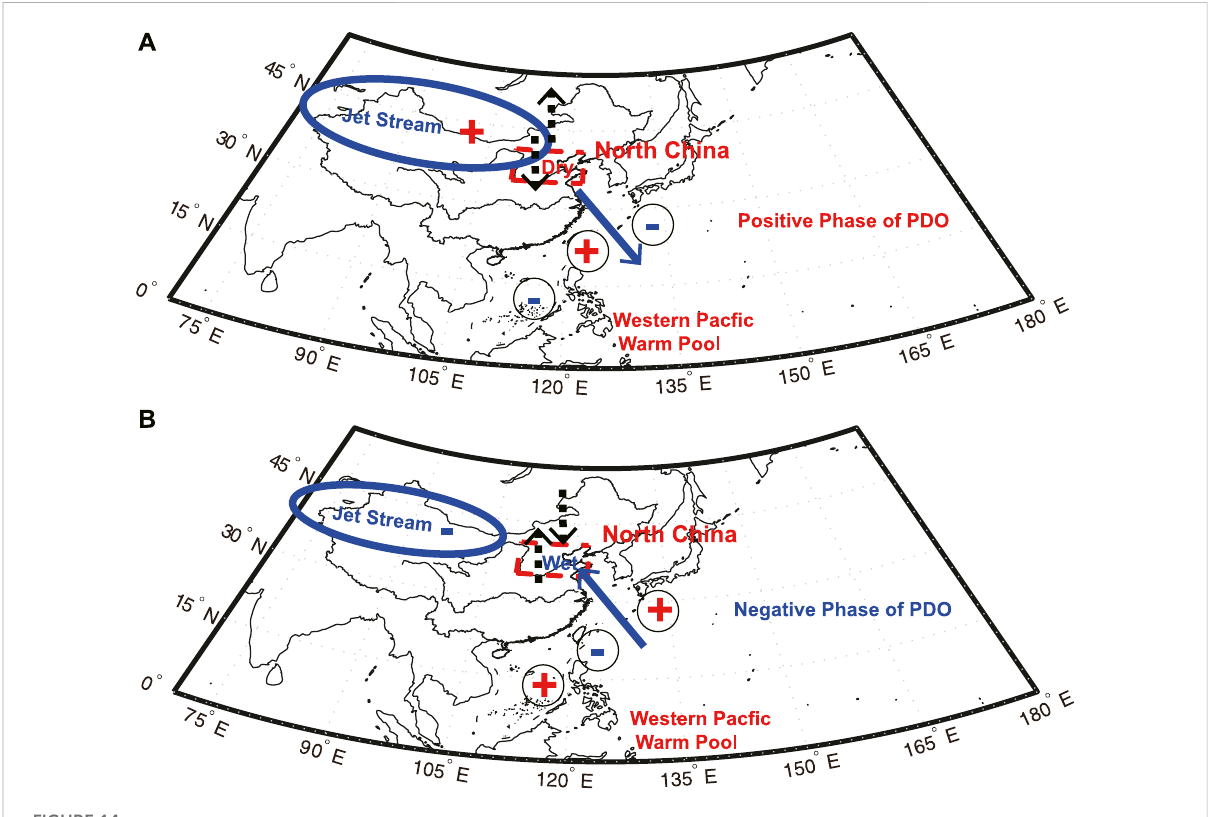
FIGURE 14 SchematicdiagramofamechanismfortheabnormalsummerrainfalloverNorthChinadueto (A) positivephaseofPDOduring1979 – 2005and (B) negative phase of PDO during 2006 –